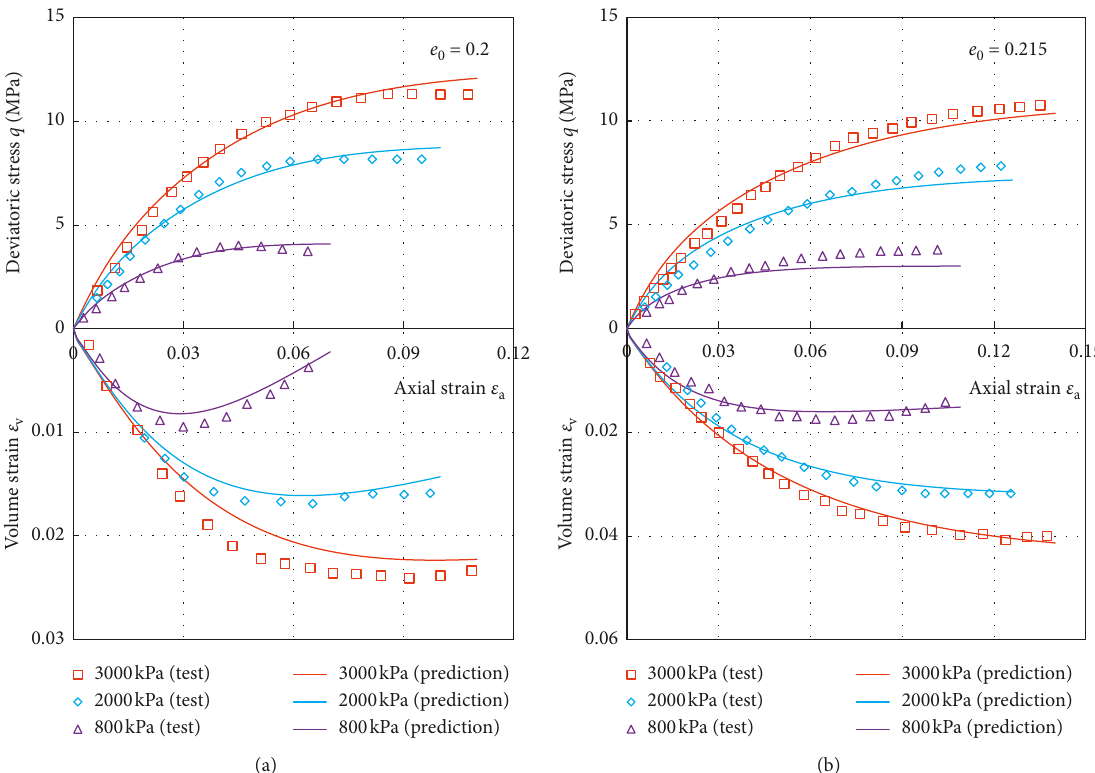
Figure 7: Experimental data and numerical predictions of the enhanced model by introducing Equation (18): (a) coarse granular soil I; (b) coarse granular soil